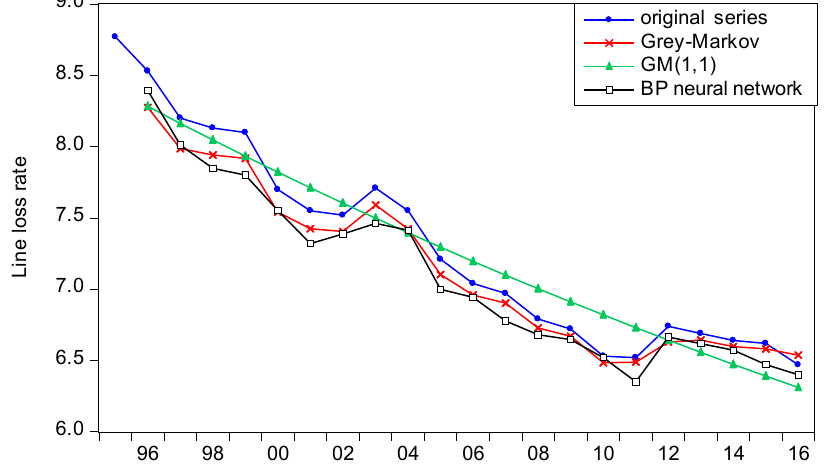
6.0 Figure 7. The forecasting results for line loss rate. Figure 7. The forecasting results for line loss